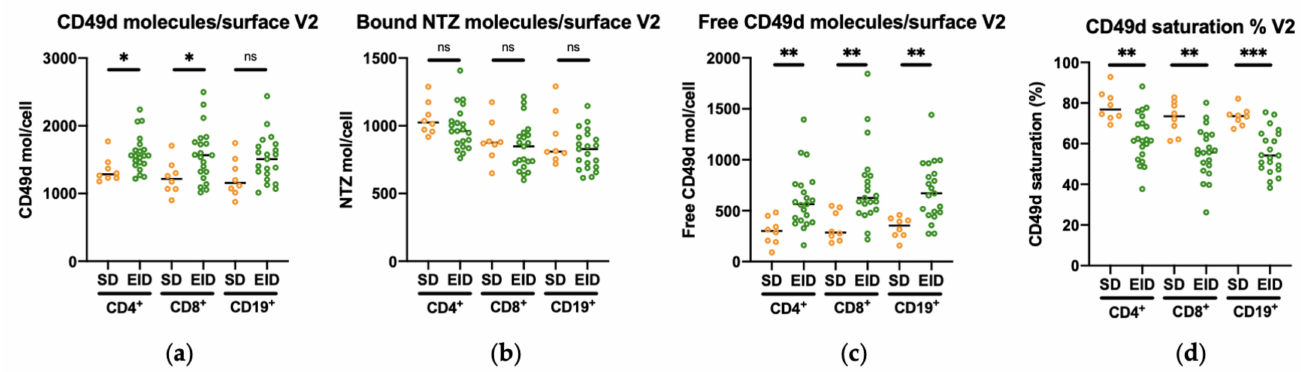
Figure A3. CD49d surface molecules levels and saturation percentage in CD4 + and CD8 + T lymphocytes, and CD19 + B lymphocytes in RRMS patients under Natalizumab treatment in SD or EID. Mean of ( a ) CD49d molecules/cell surface, ( b ) bound NTZ/cell surface, ( c ) free CD49d molecules/cell surface, and ( d ) CD49d saturation percentage in CD4 + and CD8 + T lymphocytes, and CD19 + B lymphocytes in the SD ( n = 8) and EID ( n = 21) groups. Each dot represents the number of PE molecules per cell for each patient in the second extraction (V2), translated into the levels of the corresponding antibodies (anti-CD49d PE and huIgG4 Fc PE). EID, extended interval dosing; NTZ, natalizumab; SD, standard dosing. ns: p > 0.05,